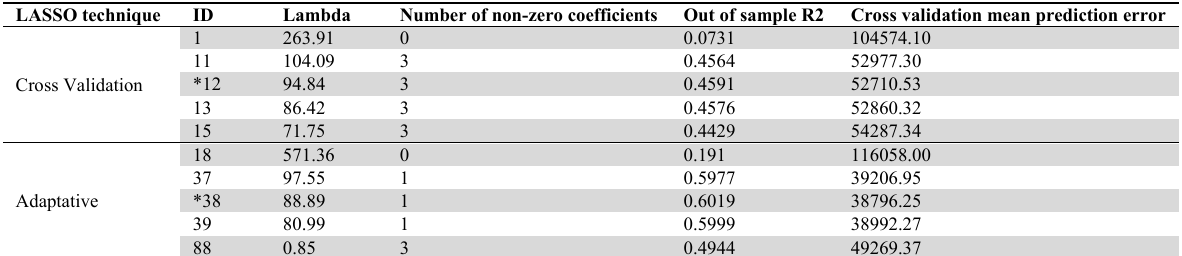
Lasso estimation